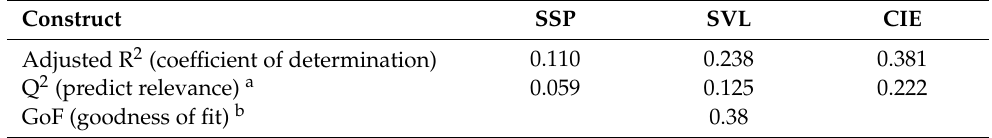
Table 7. The validity of the structural equation